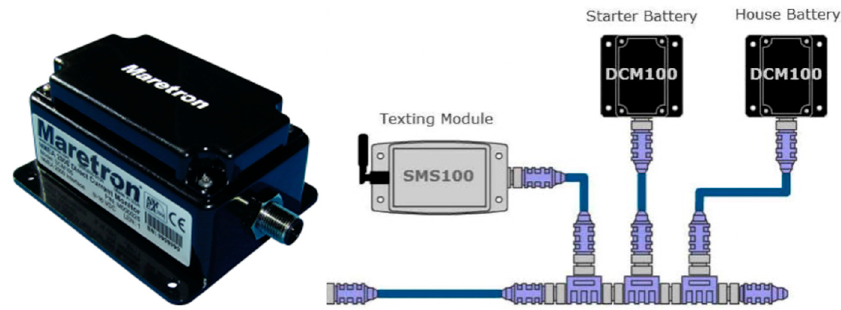
Figure 3. DCM100 direct current/battery module monitor [71].